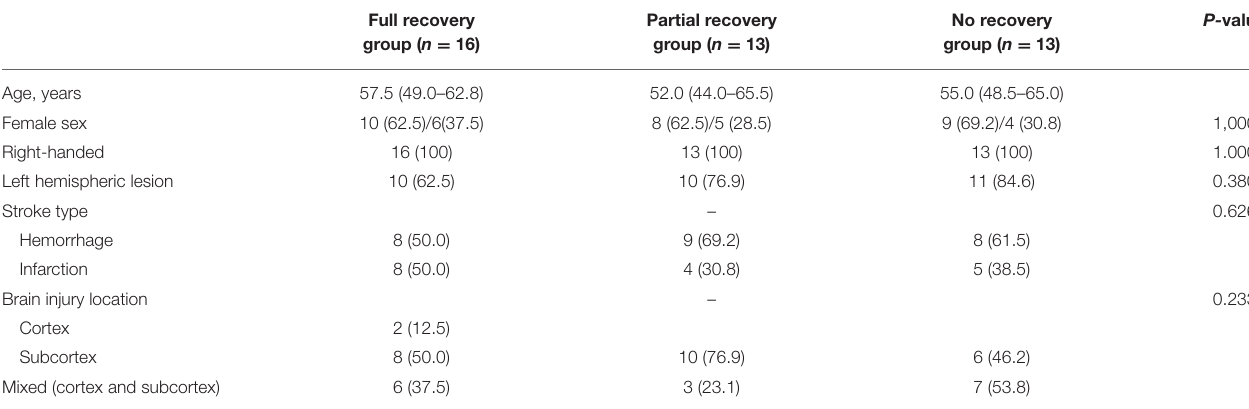
TABLE 1 | Participants’ demographic data.